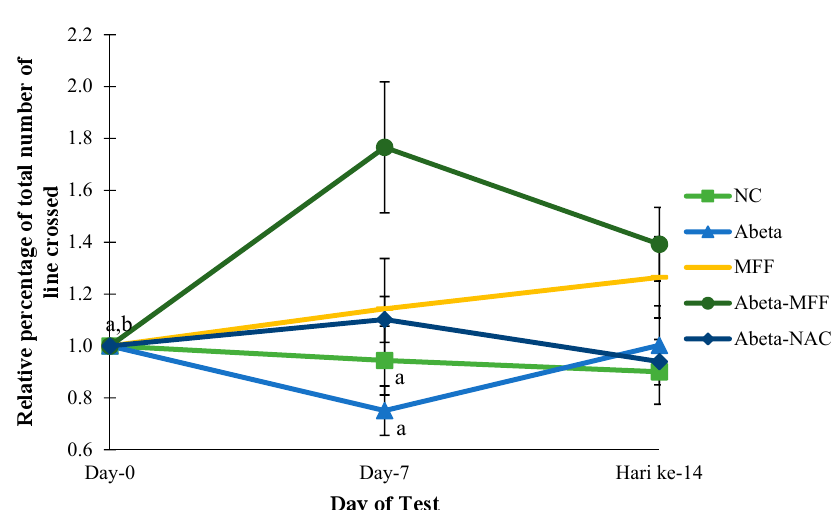
Figure 3. Comparison of the relative percentage of the total numbers of lines crossed between the groups on day 0, day 7 and day 14. Every bar represents the mean ± SEM ( n = 5). a p < 0.05 compared to Abeta–MFF on day 7. b p < 0.05 compared to Abeta–MFF day 14.